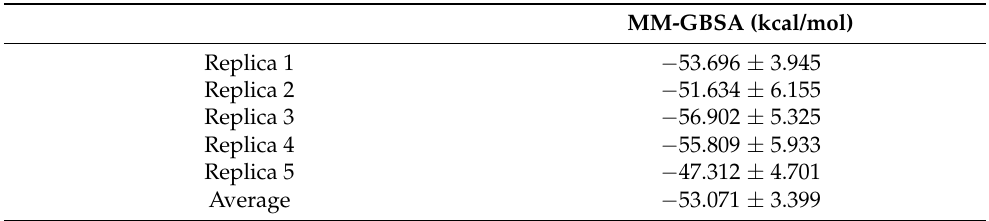
Figure 5. Simulation of itraconazole–NS1 interaction by molecular dynamics. ( A ) Final frames from simulation replicas highlighting the ITC position conservation throughout the simulations. ( B ) Stable, favorable interaction energies obtained from the simulations (dark colors—average; lighter colors— standard deviation). ( C ) NSI–ITC interactions observed for at least 70% of the simulation time. Table 2. Estimated ligand-binding free energy.